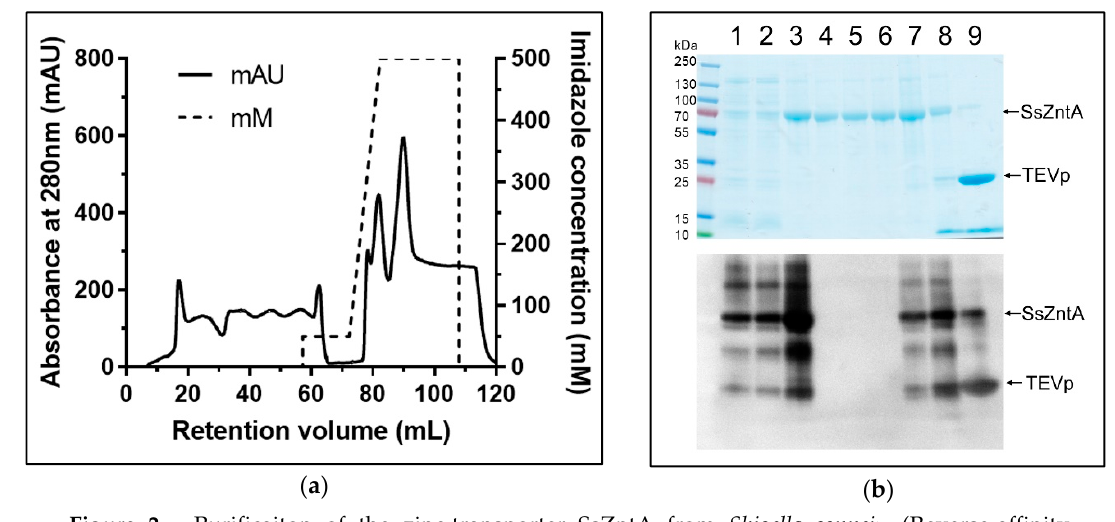
Figure 2. Purificaiton of the zinc-transporter SsZntA from Shigella sonnei : (Reverse-affinity chromatography) R-IMAC. ( a ) Reverse (second) affinity chromatography profile: The first 60 mL represent the flow-through containing cleaved SsZntA (without HisTag); at 80 mL, corresponding to 250 mM imidazole, uncleaved SsZntA is eluted; while at 90 mL, at 500 mM imidazole, HisTagged TEVp is eluted. ( b ) On top, Coomassie stained sodium dodecyl sulfate-polyacrylamide gel electrophoresis (SDS-PAGE), and on the bottom, Western blot anti-HisTag; lane 1: Solubilized membranes, lane 2: Clarified solubilized membranes, lane 3: Affinity-chromatography purified SsZntA (with HisTag), lanes 4 to 6: Flow through of reverse affinity chromatography (SsZntA without HisTag) corresponding to retention volume from 0 mL to 60 mL, lanes 7 to 9: Eluted fractions corresponding to retention volume of 80, 85, and 90 mL, respectively.